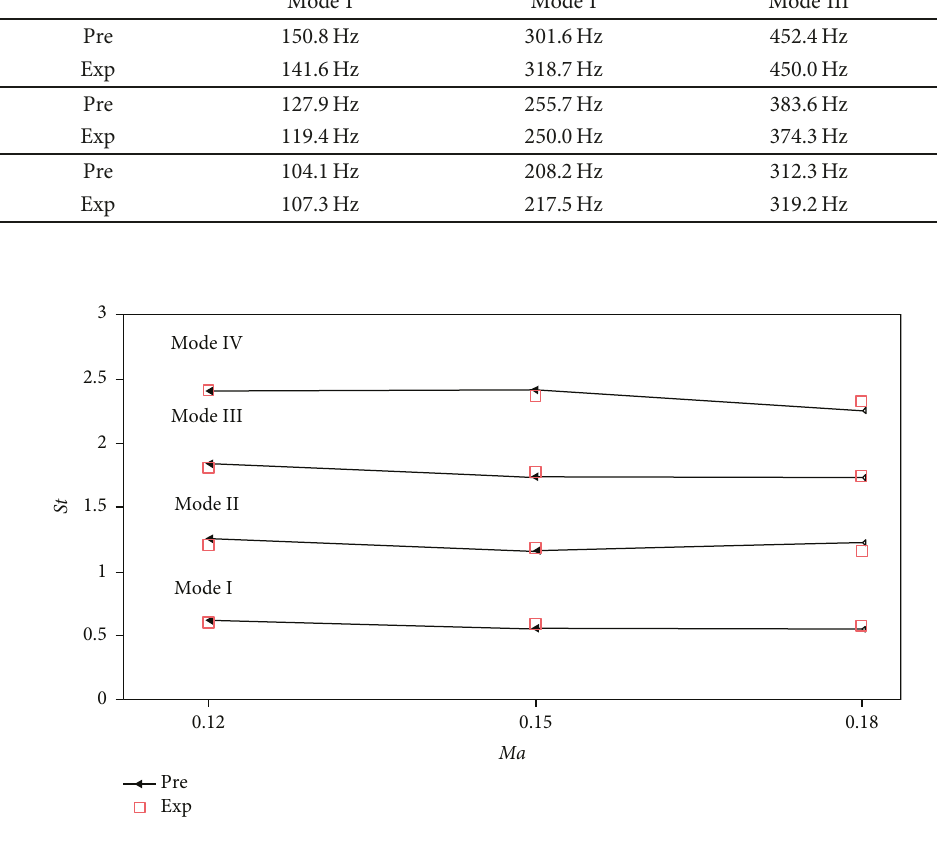
Figure 11: Comparison between the prediction and experimental results on the acoustic modes of the test cases as a function of the Mach number.